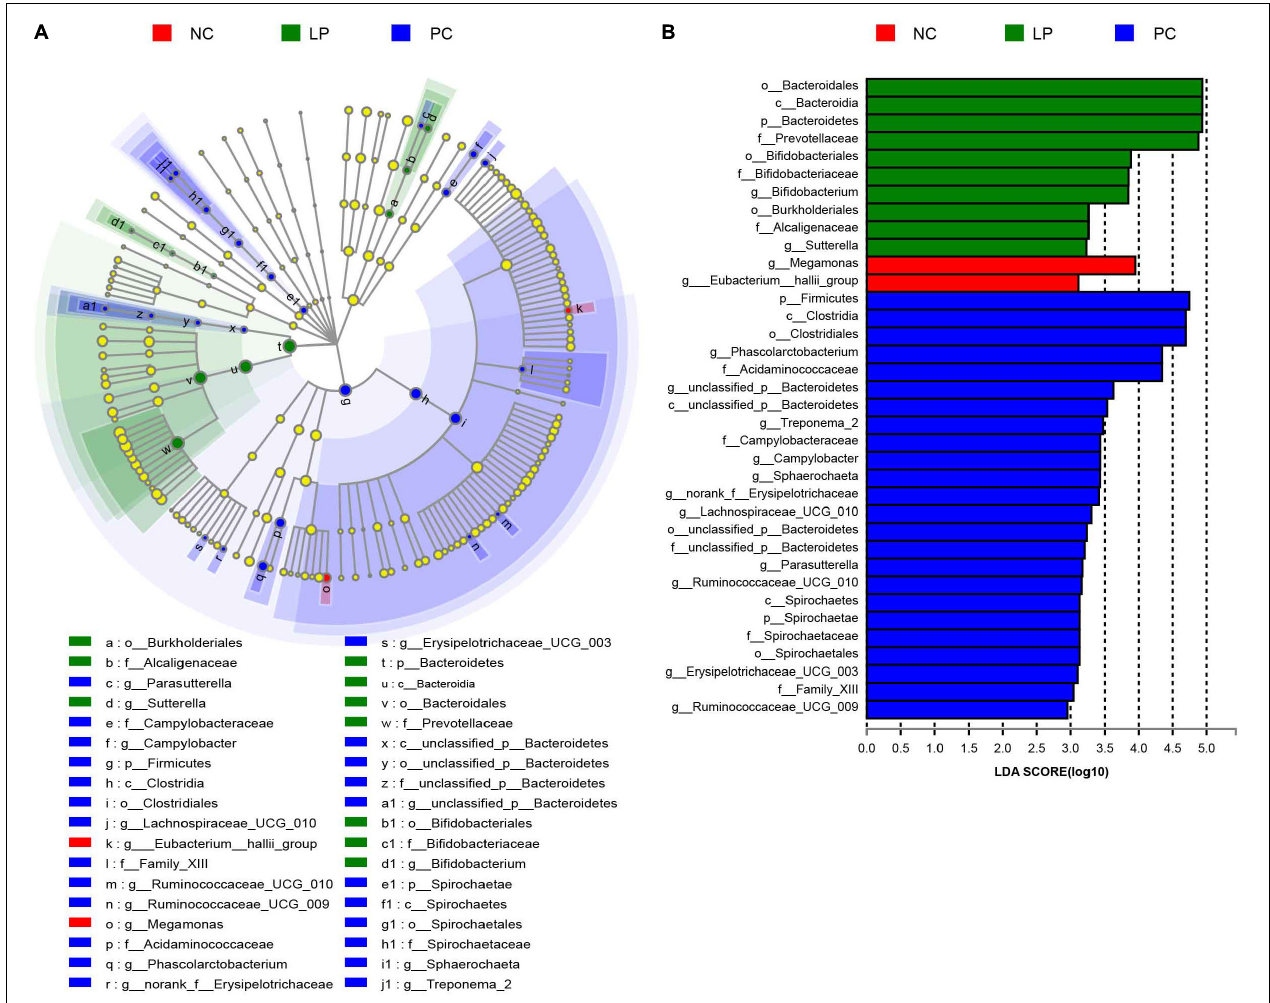
FIGURE 3 | LefSe analysis of colonic microbial community in weaning piglets from NC, PC, and LP groups. (A) Cladogram showing microbial species with significant differences in NC, LP, and PC groups. Red, green, and blue indicate different groups, with the species classification at the level of phylum, class, order, family, and genus shown from the inside to outside. The red, green, and blue nodes in the phylogenetic tree represent microbial species that play important roles in the NC, LP, and PC groups, respectively. Yellow nodes represent species with no significant difference. (B) Species with significant difference that have an LDA score greater than the estimated value with the default score 3. The length of the histogram represents the LDA score indicating the difference of species in the three